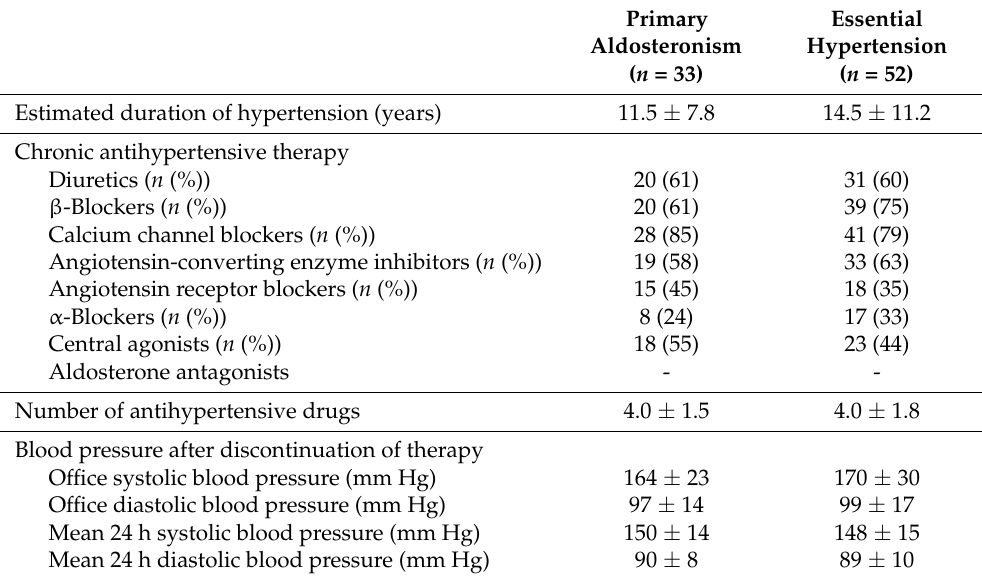
Table 3. Use of antihypertensive drugs and blood pressure levels in both hypertensive